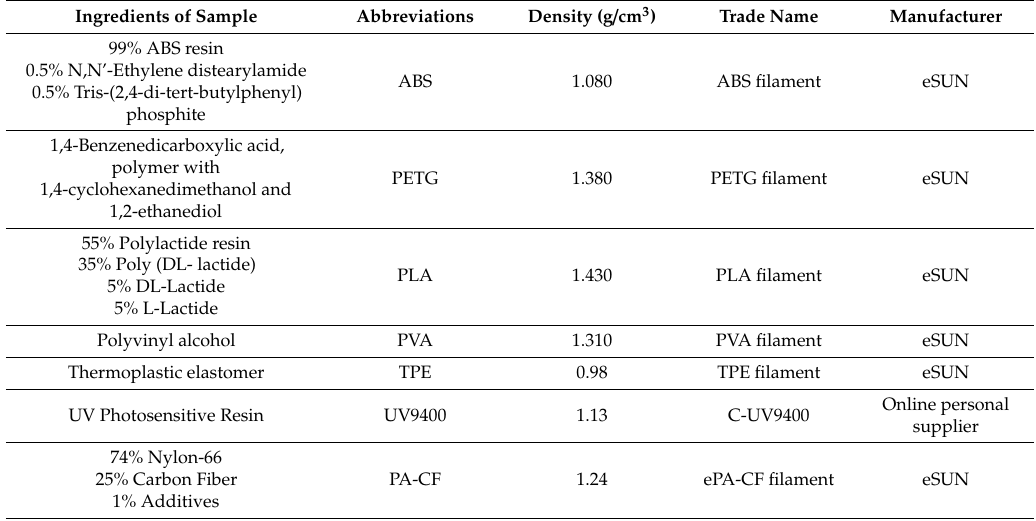
Table 1. Ingredients, abbreviations, density, and other information of 3D printing polymer.